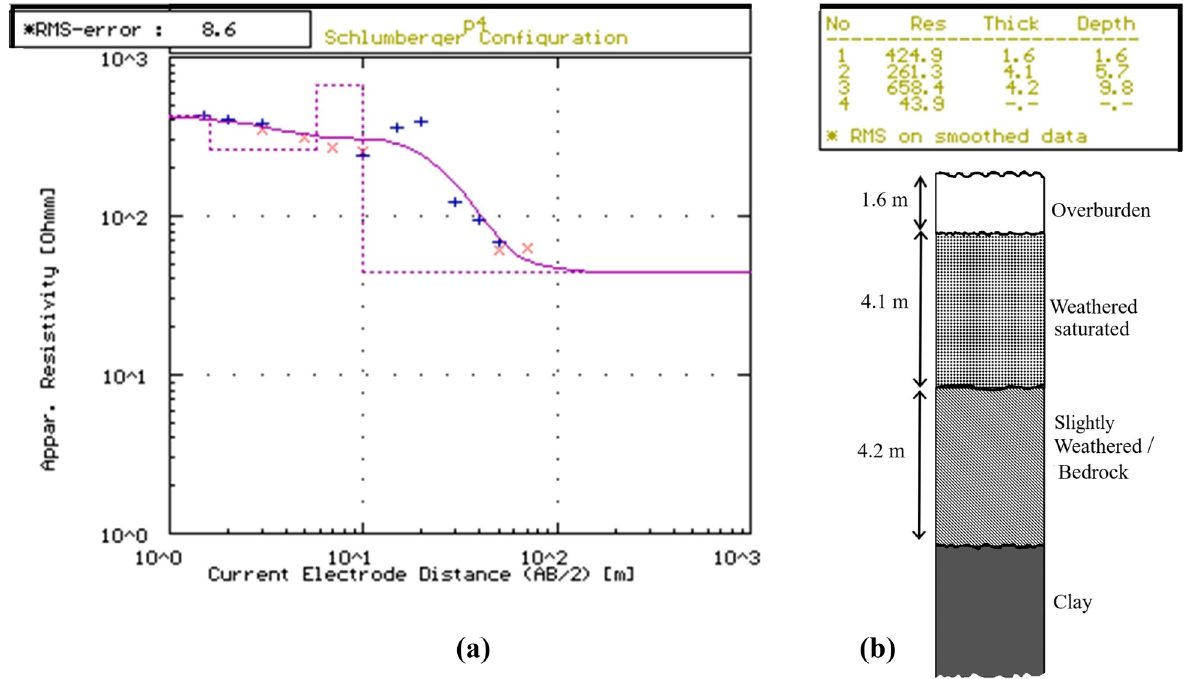
Fig. 7 a Curve matched from RESIST software for P4, b Geological profile for P4